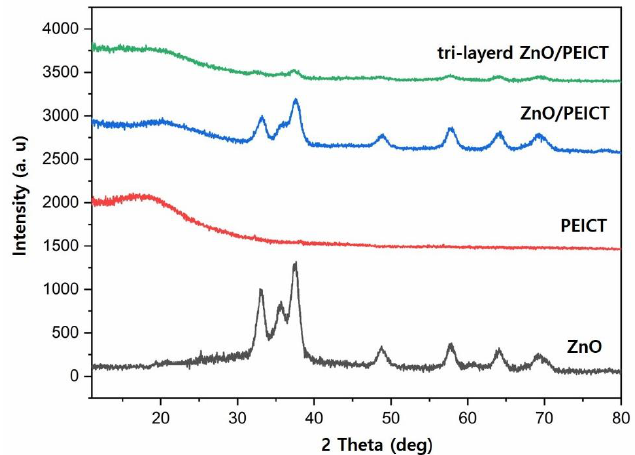
Figure 5. XRD patterns of the ZnO nanoparticle, the PEICT nanofiber mat, the ZnO / PEICT composite nanofiber upon the removal of TFA, and tri-layered nanofiber mat by sequential electrospinning process.